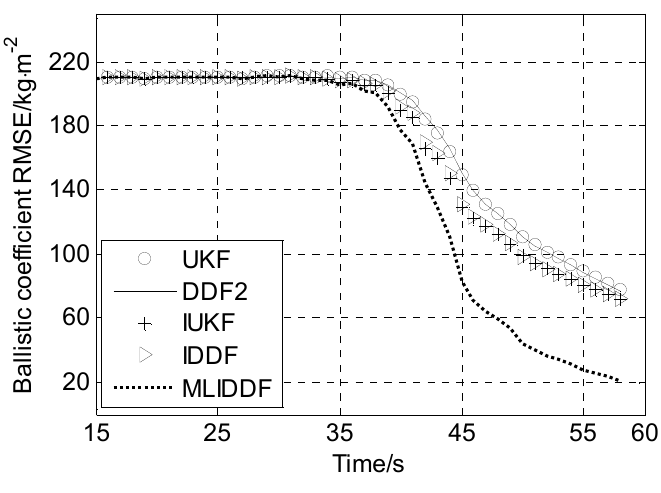
Figure 8. Ballistic coefficient RMSE s for various